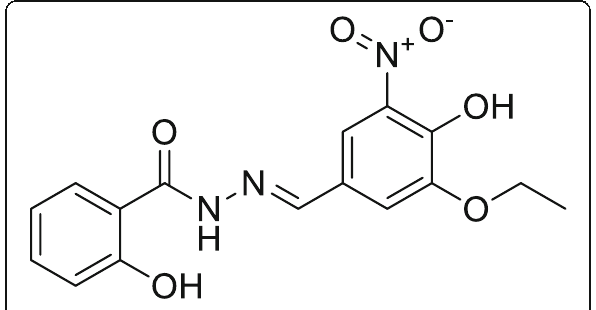
Fig. 1 The parent hydrazone molecule used as a template